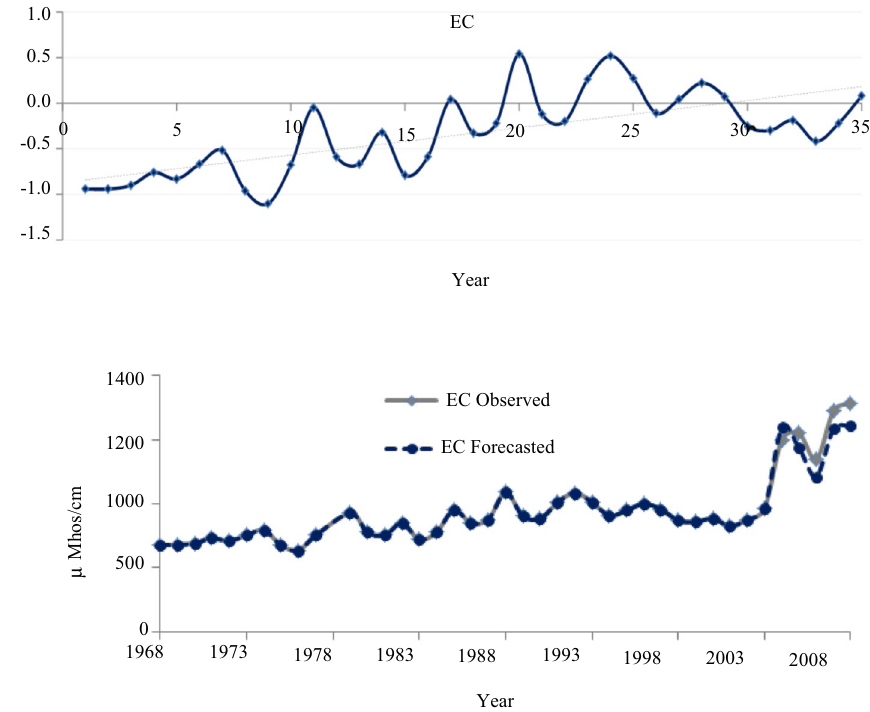
Fig. 3 Unchanging time arrangements of EC and the projected values for 5 years